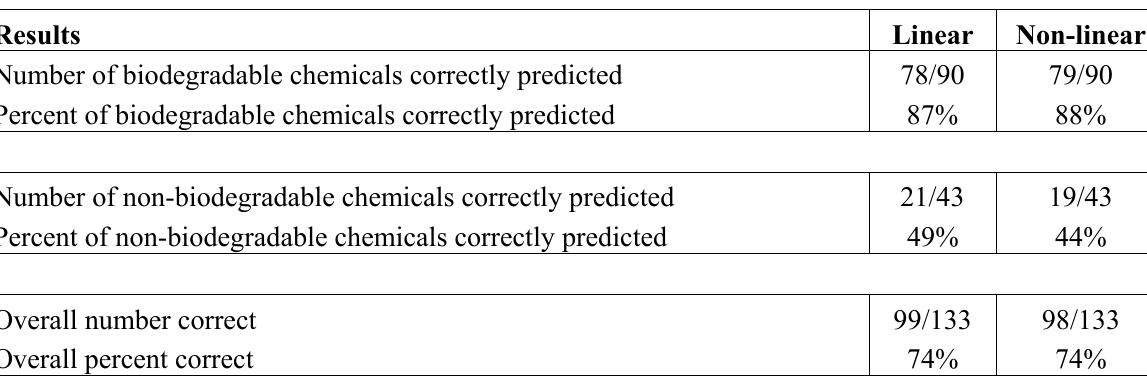
Table 9. Results of comparison of BIOWIN against DIPPR BOD/ThOD